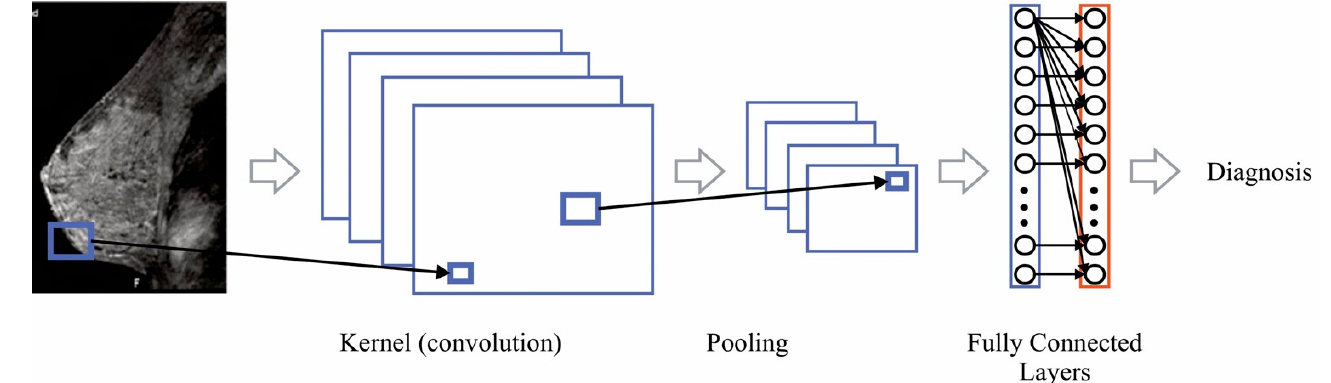
Figure 6. Convolutional Neural Network.